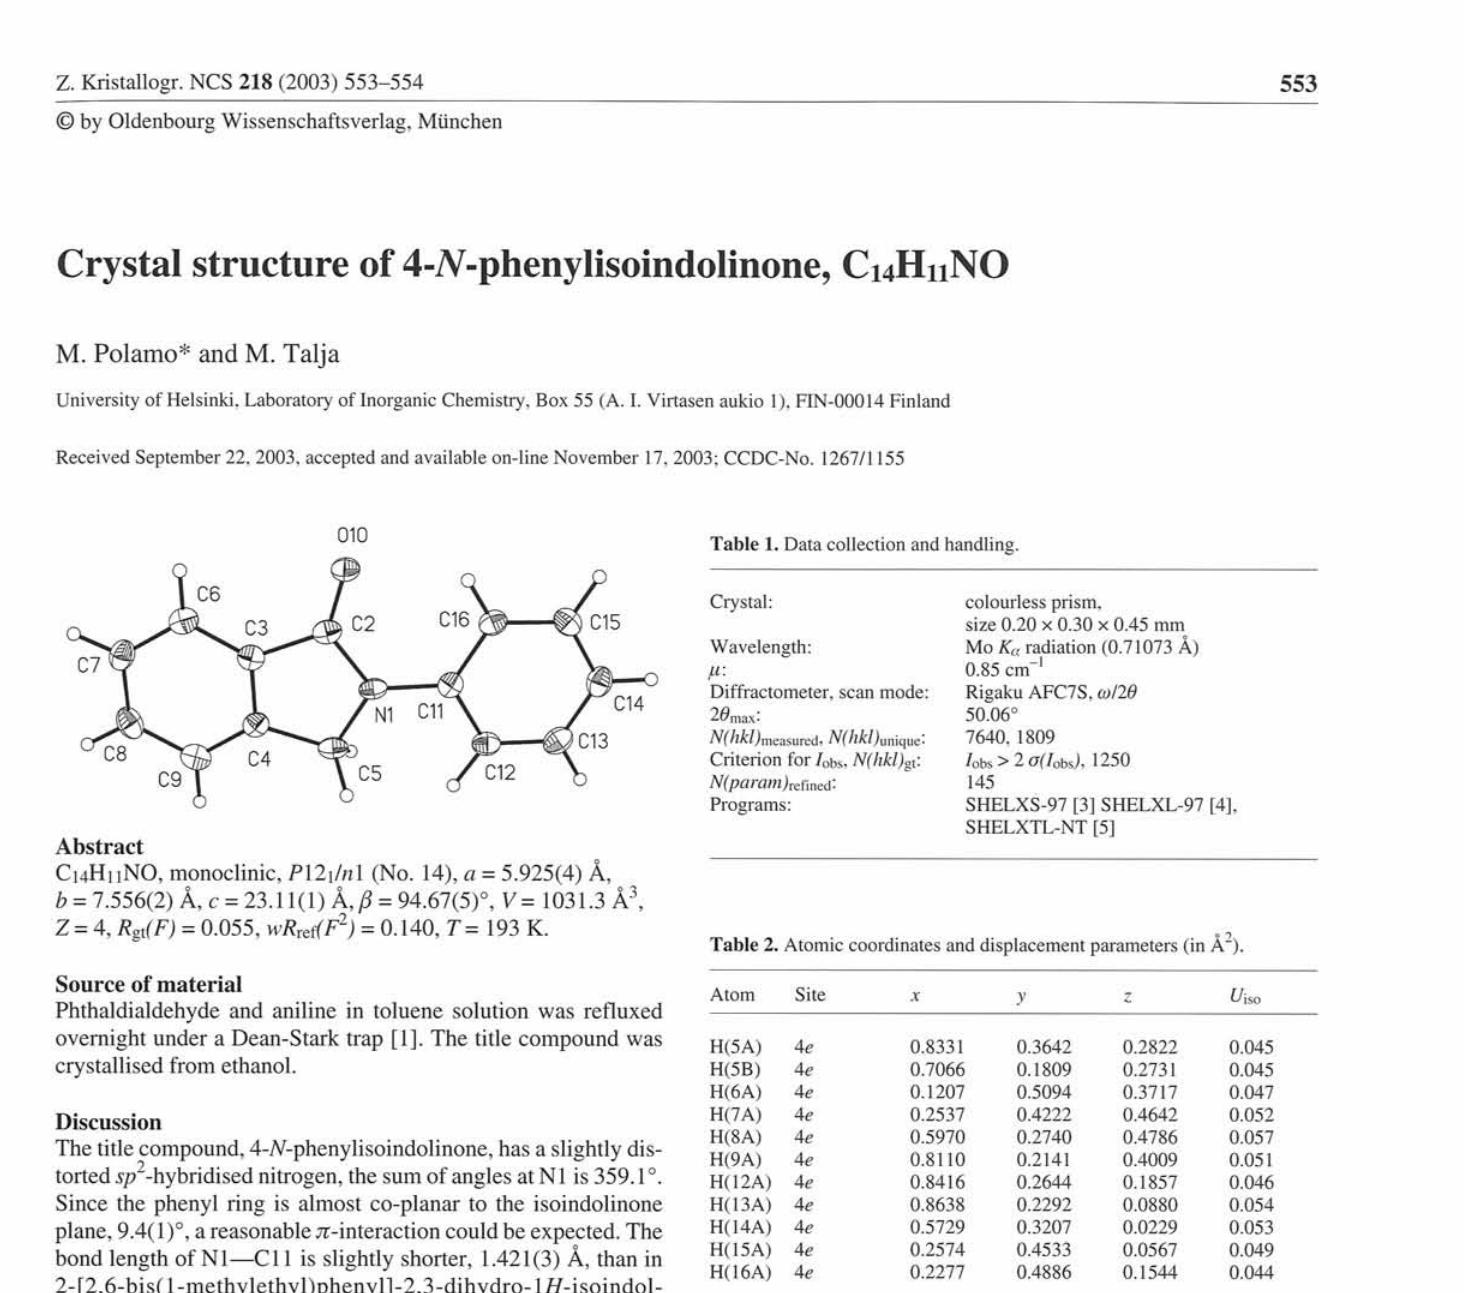
Table 3. Atomic coordinates and displacement parameters (in Â 2